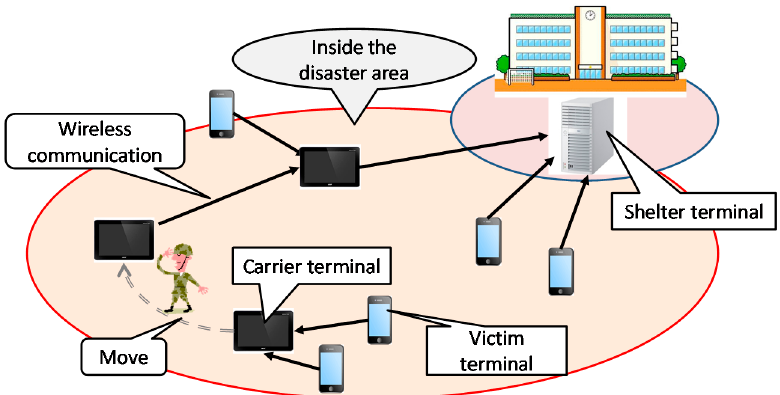
Figure 1. Delay/disruption Tolerant Networks (DTN) structure in a disaster